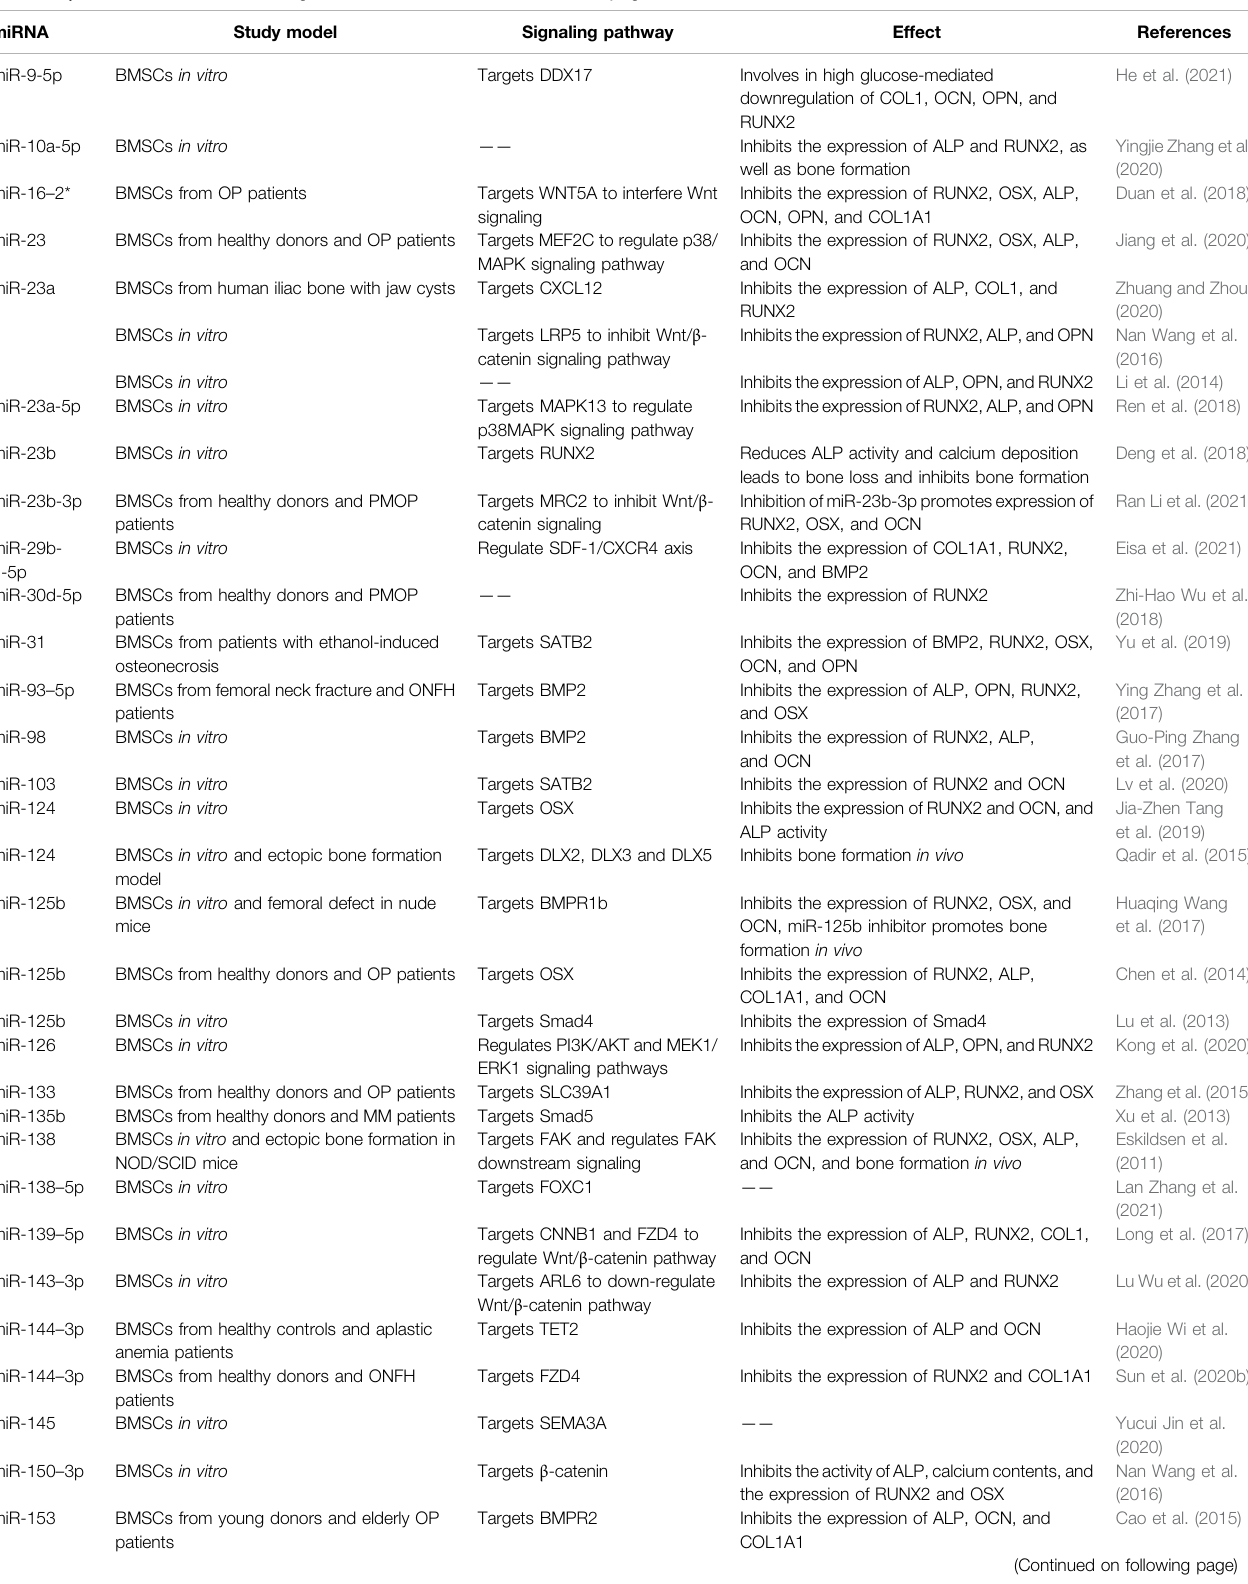
TABLE 2 | MiRNAs that inhibit the osteogenic differentiation in BMSCs and underlying mechanisms.